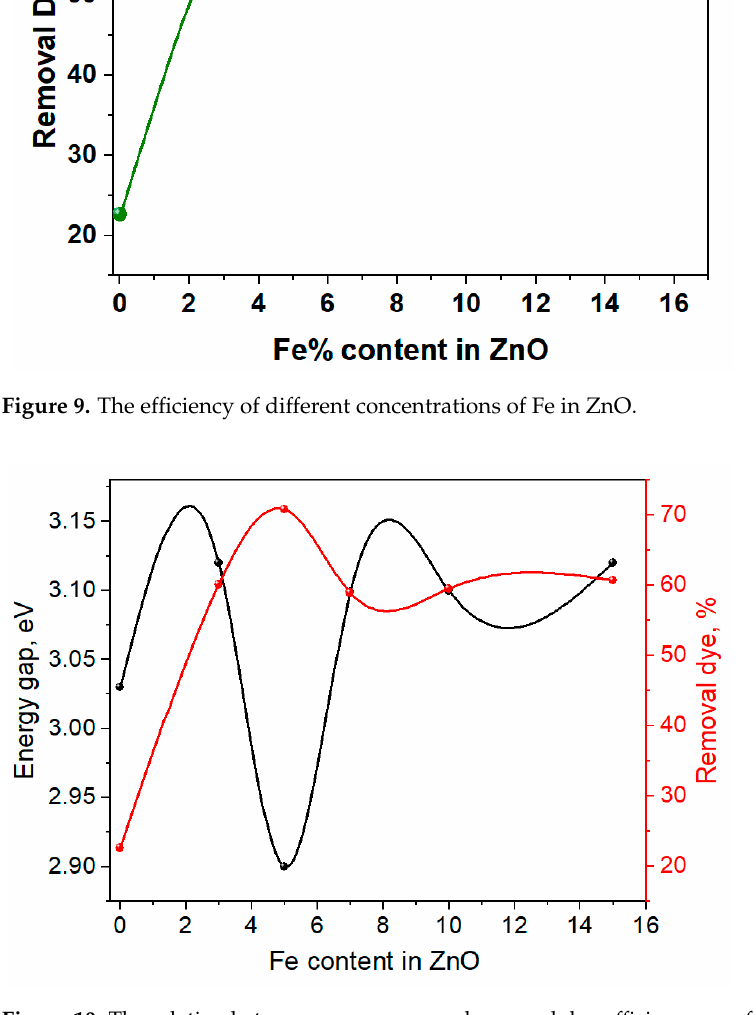
Figure 10. The relation between energy gap and removal dye efficiency as a function of Fe concen- trations in ZnO.